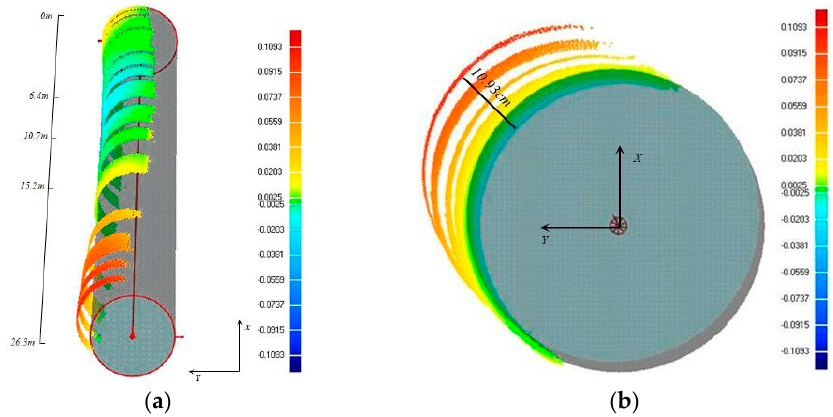
Figure 12. Color map analysis: ( a ) Color maps of deformations; ( b ) Top view of color maps